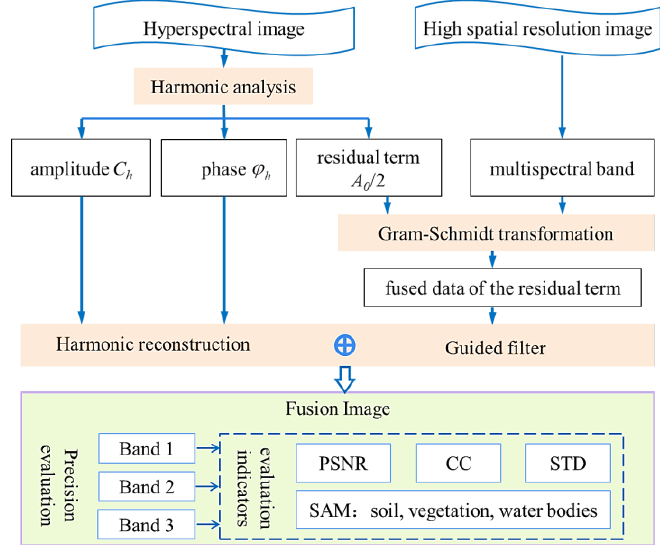
Figure 1. HGF spatial – spectral fusion model.